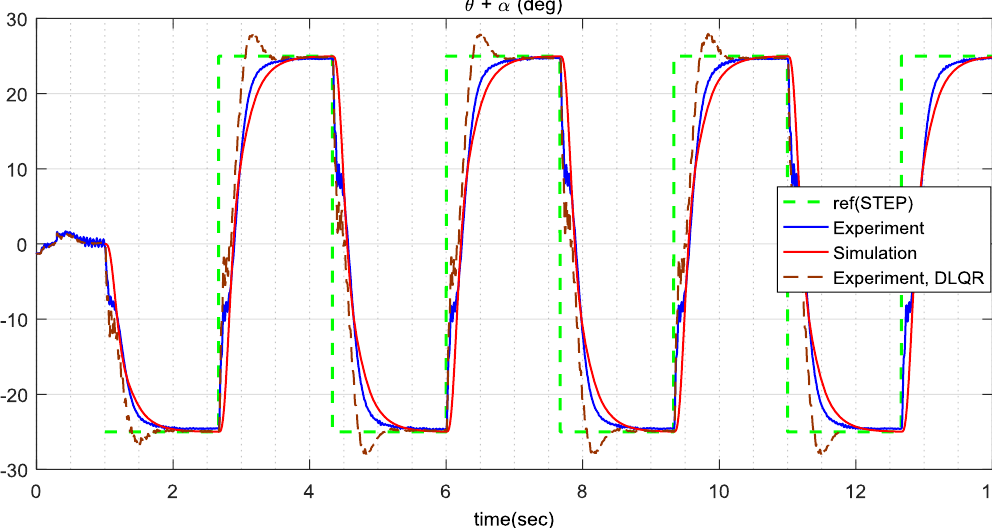
Figure 9. Controller response for